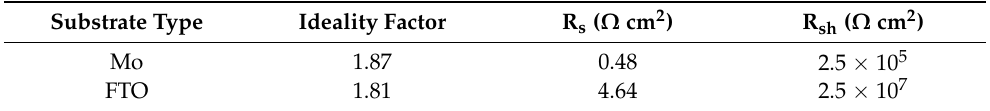
Table 1. Electrical parameters of Cu-doped Sb 2 Se 3 solar cells on Mo and FTO substrates calculated from IV characteristics under dark conditions at